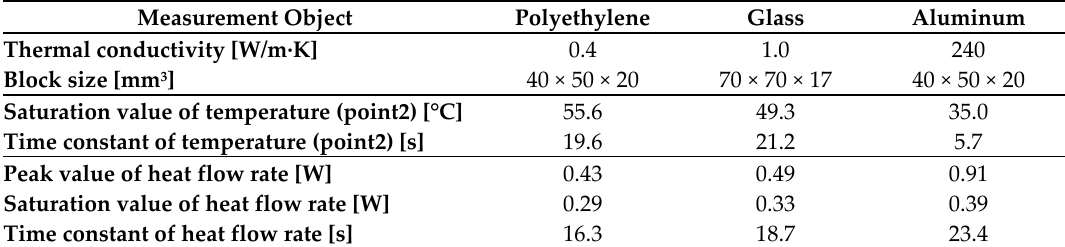
Table 1. Measured temperatures and heat flows with polyethylene, glass, and aluminum.